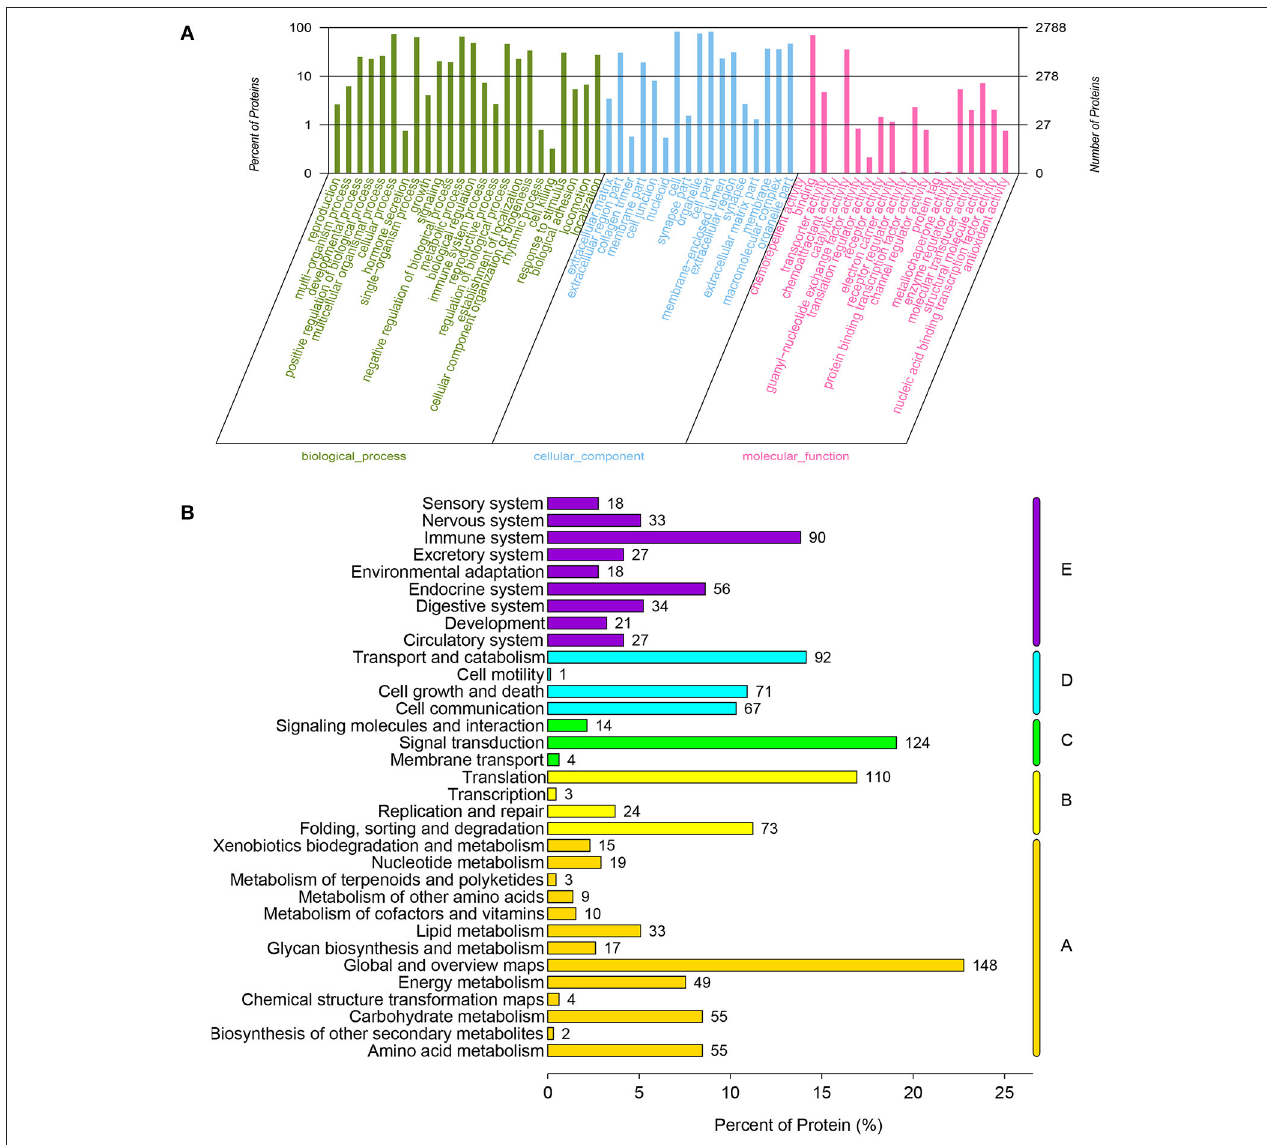
FIGURE 1 | Functional classification of all annotated proteins in chicken embryonic muscle. (A) Proteins as classified into three main categories by GO analysis: biological process, cellular component, and molecular function. The left y-axis indicates the percentage of a specific category of genes in that category. The right y-axis indicates the number of genes in a category. (B) Proteins as classified into five main categories by KEGG analysis: metabolism, genetic information processing, environmental information processing, cellular processes and organismal systems. The x-axis indicates the percentage genes within that specific